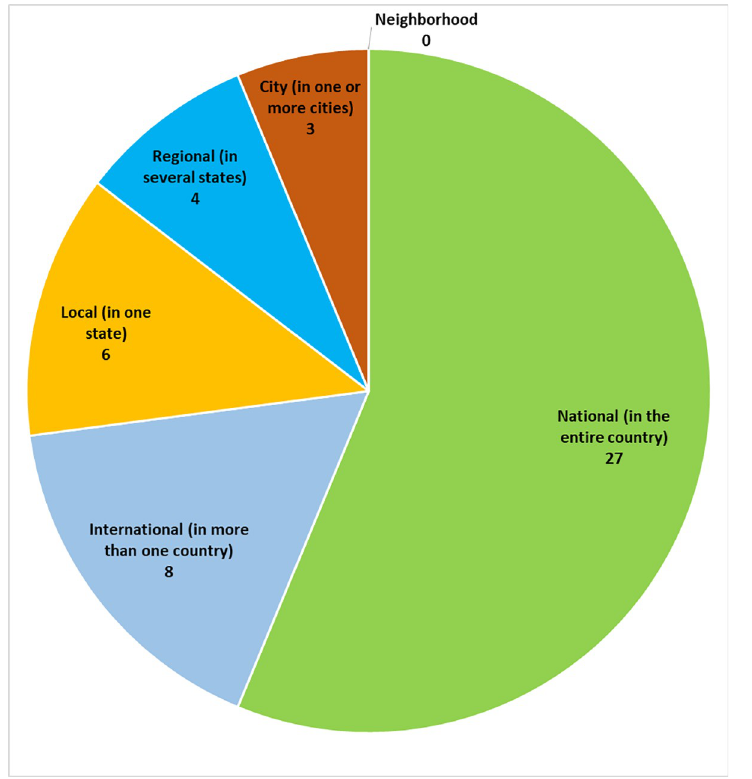
Fig 2. Geographic scope of participating